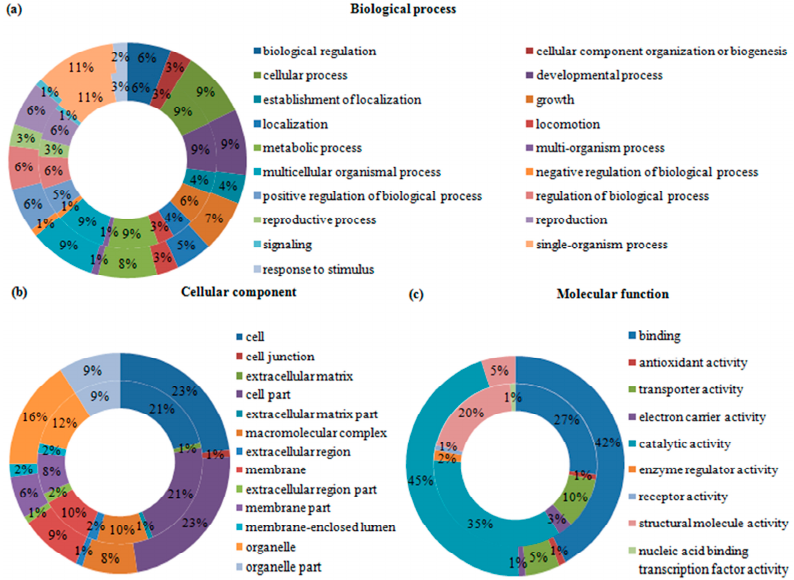
Figure 2. Gene ontology (GO) terms were assigned to the significantly up-regulated transcripts and proteins in highly and weakly virulent Bursaphelenchus mucronatus ( B. mucronatus ) isolates. The percentage of each category shown is based on the three groups: ( a ) biological process; ( b ) cellular component; and ( c ) molecular function. External ring = protein; internal ring = transcript.